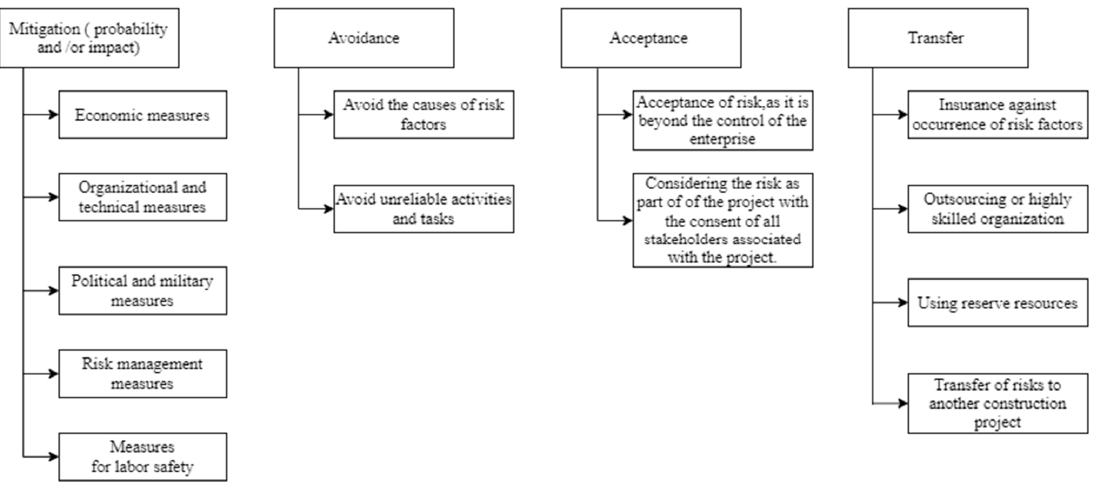
Figure 4. Compensatory measures to reduce or limit the impact of risk factors.